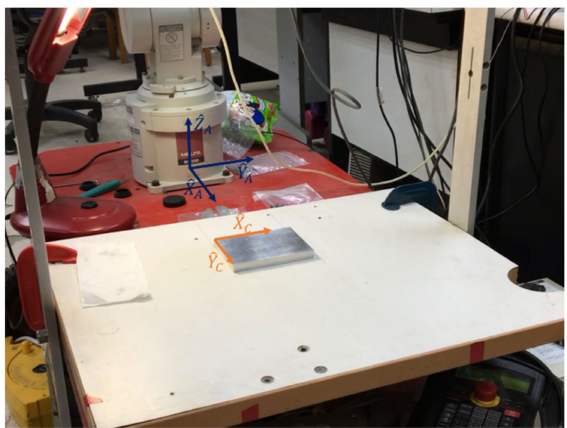
Figure 4. Positions of the coordinate systems { A } and { C }.